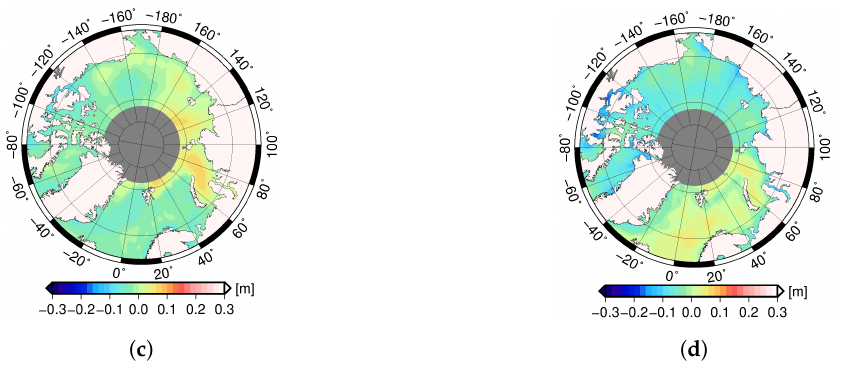
Figure 3. The average SLA in meters for each satellite period: ( a ) ERS-1, ( b ) ERS-2, ( c ) Envisat, ( d )